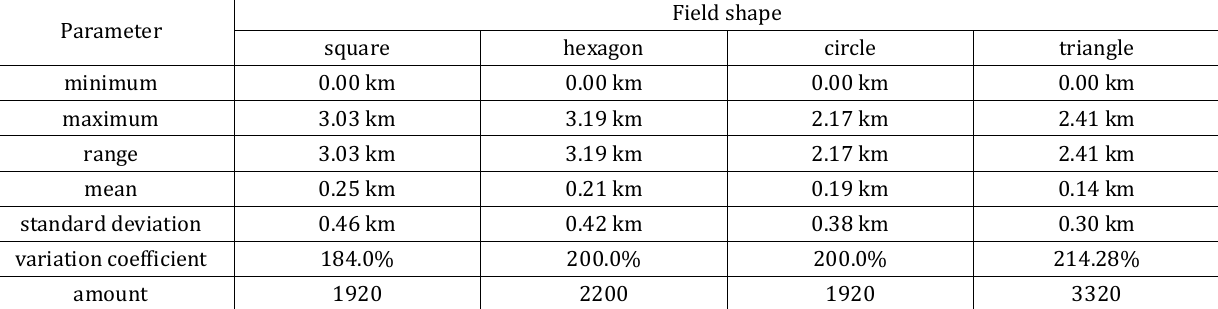
Table 3. Statistical data of basic fields (2 km)